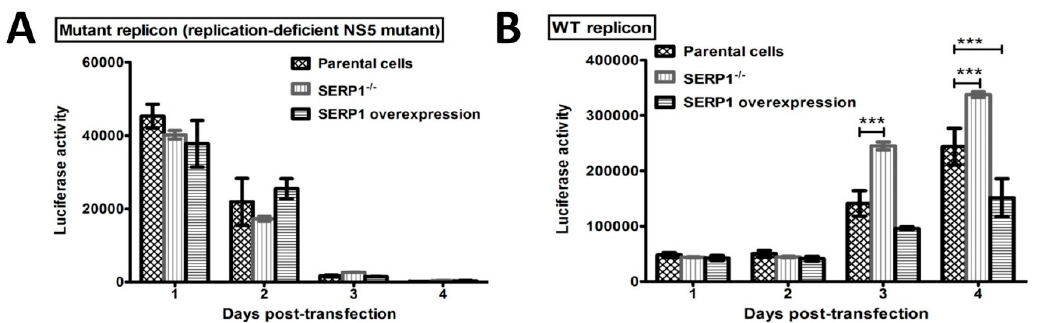
Figure 5. The e ff ect of SERP1 on the DENV-2 replicon capacity in the Huh7.5 cells. The replication activities of the transient expression of DNA-launched mutant replicon ( A ) or WT replicon ( B ) plasmids were detected in the parental cells, stable cells overexpressing SERP1, and SERP1 knockout cells. The luciferase activity of the transfected cells was measured at 1, 2, 3, and 4 d.p.t. The error bars represent the SEMs from three independent experiments. The di ff erences in the luciferase activity between the transfected cells at 3 or 4 d.p.t. were analyzed using Student’s t-test. ***, p < 0.001 (relative to the parental